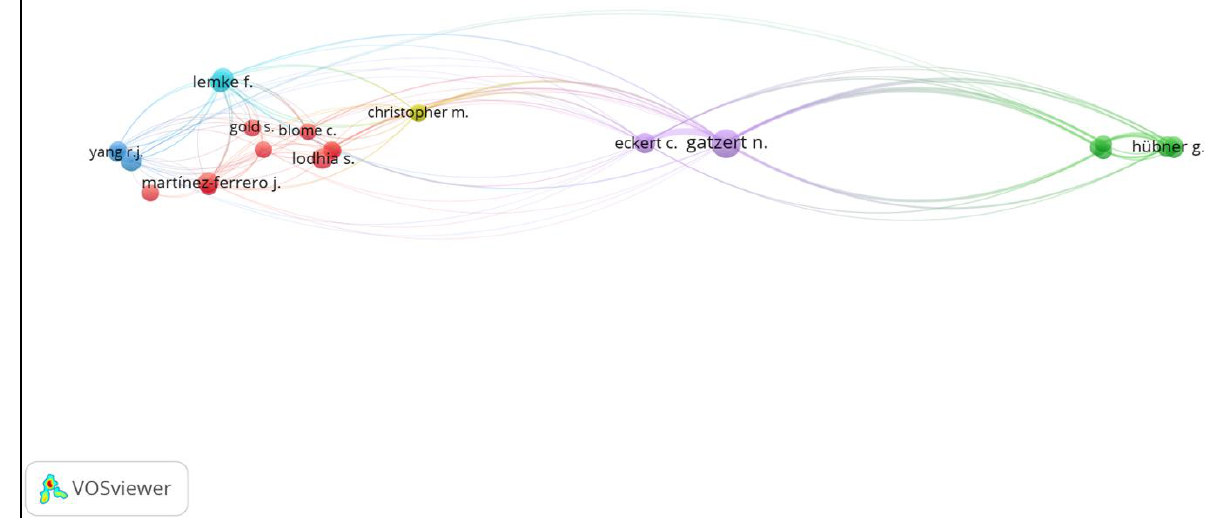
Figure 6. Author-wise published reputation risk papers map